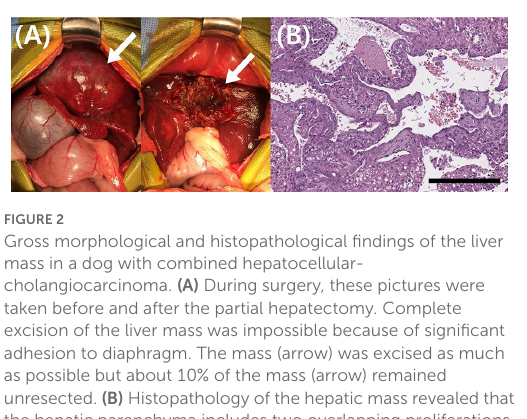
FIGURE1 Computed tomography of a dog with combined hepatocellular-cholangiocarcinoma. (A) Sagittal view showing a left medial liver lobe multicystic mass (arrow) with adhesion to diaphragm and caudal vena cava. (B) Plain and (C) postcontrast axial view of the cranial abdominal region showing a hypoattenuated liver mass (arrows) with minimal contrast enhancement.